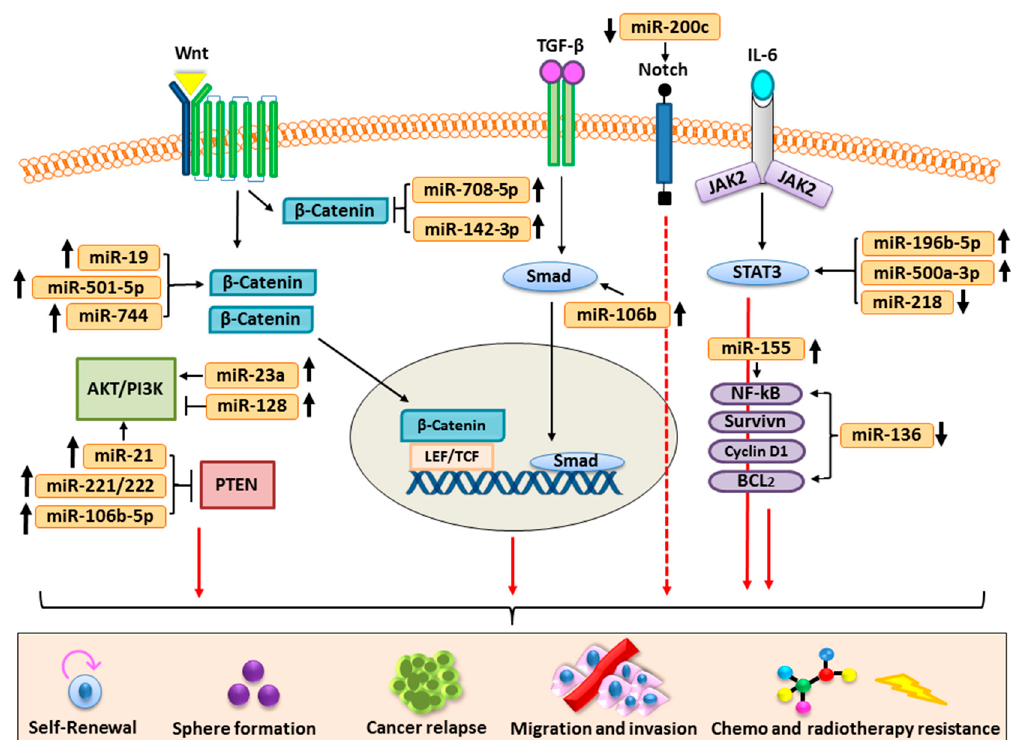
Figure 3. Mechanistic overview of miRNA-mediated regulation of the stemness of cancer stem cells via targeting signaling pathways: miRNAs can act as both suppressive and enhancer of stem cells features such as self-renewal, sphere formation, cancer relapse, migration, invasion, and chemo- and radiotherapy resistance. Via targeting the Wnt / β -catenin signaling pathway, many miRNAs regulate the stem cell features by targeting β -catenin. Upregulation of miR-19, miR-501-5p, and miR-744 stimulates the activation of β -catenin. Hence, it is translocated to the nucleus and stimulates gene expression. Conversely, upregulation of miR-708-5p and miR-142-3p inhibits β -catenin activation and prevents its accumulation in the cytoplasm. Another signaling pathway targeted by miRNAs is AKT / PI3K / PTEN. MiR-21, miR-221 / 222, and miR-106b-5p upregulation inhibit the function of PTEN. Furthermore, upregulation of miR-21 and miR-23a stimulate the activation of the AKT / PI3K pathway, whereas upregulation of miR-128 inhibits its activation. Upregulation of miR-106b is found to act on TGF- β through targeting Smad. Downregulation of miR-200c stimulates the activation of Notch pathways and, hence, enhances CSC features. Another important signaling pathway associated with CSC development is the JAK / STAT pathway. Upregulation of miR-196b-5p and miR-500a-3p and downregulation of miR-218 stimulate the activation of STAT3 molecule. Further, downregulation of miR-136 stimulates CSCs as a result of activating various proteins including NF-kB , survivin , cyclin D1 , and Bcl2 . In addition, upregulation of miR-155 activates NF-kB. Taken together, the stem cell features can be stimulated or suppressed by miRNA-regulated expression of signaling proteins.